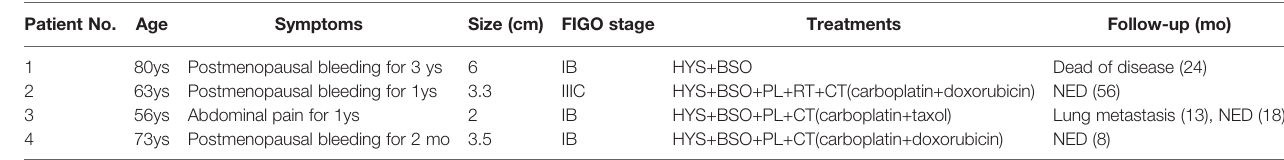
TABLE 1 | Clinical features of uterine corpus mesonephric-like adenocarcinomas. Patient No. Age